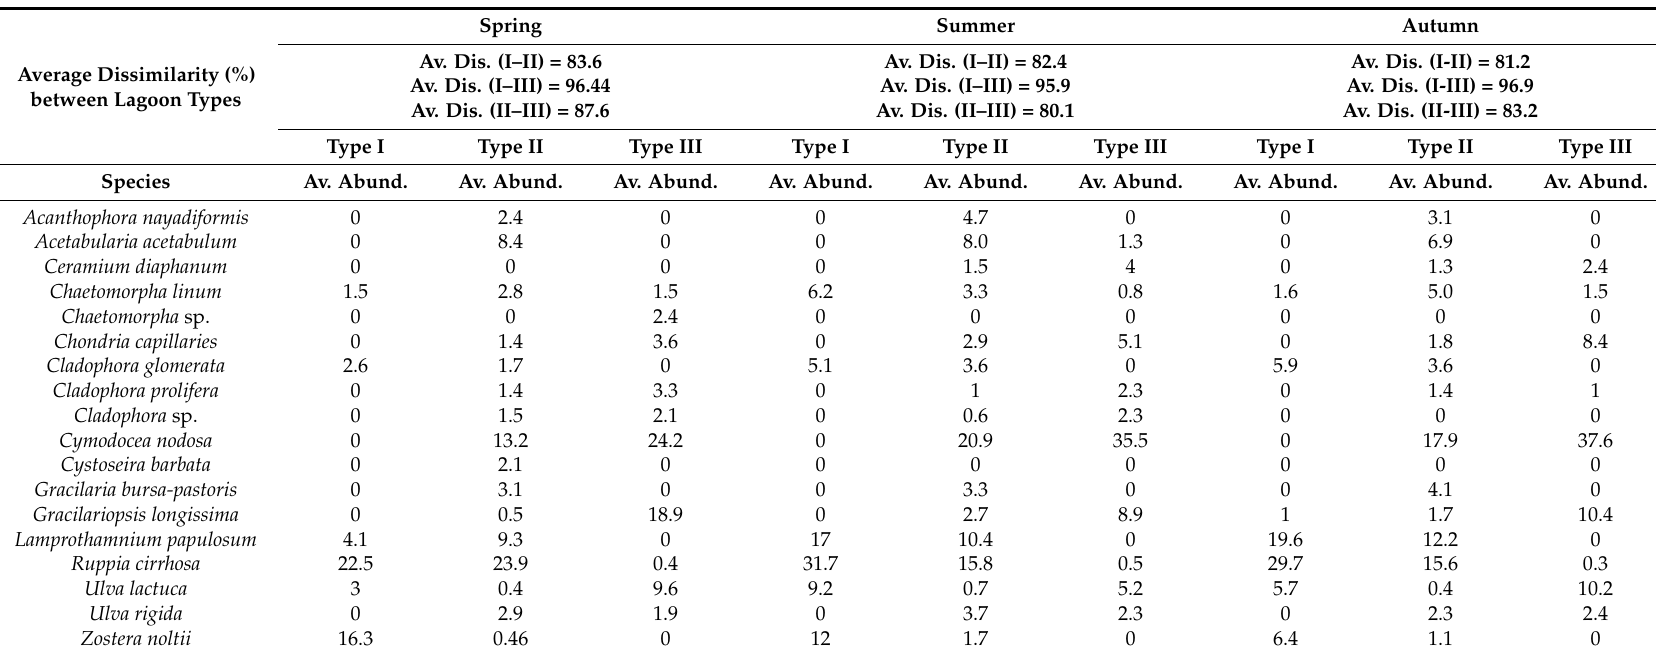
Table 4. SIMPER (similarity percentage) analysis results: average dissimilarity (%) within the three lagoon types of Western Greece during spring, summer and autumn. The macrophyte species primarily responsible for the differences between macrophyte assemblages and its contribution within the lagoon type are also reported.